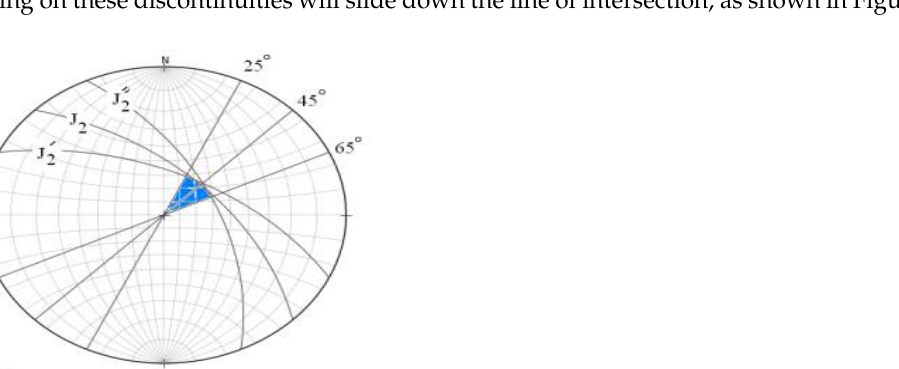
Figure 6. Plot of intersection of three joint sets on Stereonet dipping out of slope face (Adapted from [47]).